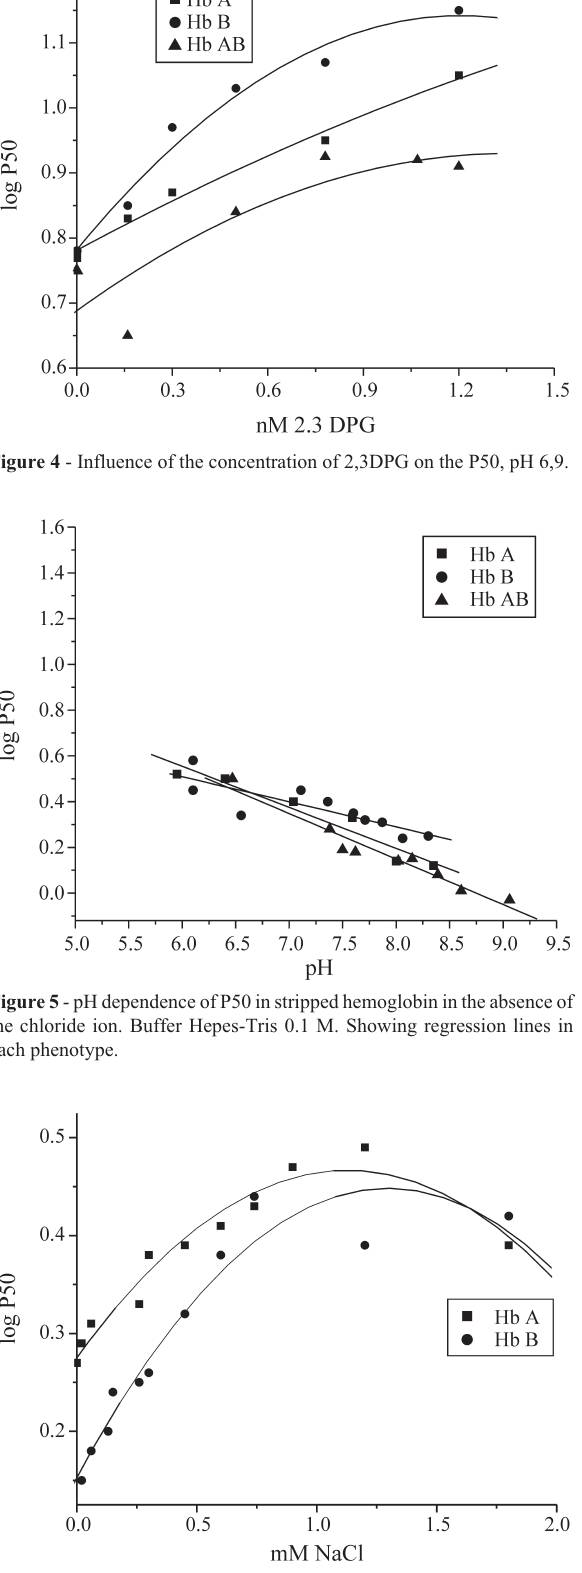
Figure 6 - Influence of the concentration of NaCl on the P50. Buffer Hepes-Tris 0.1 M, pH